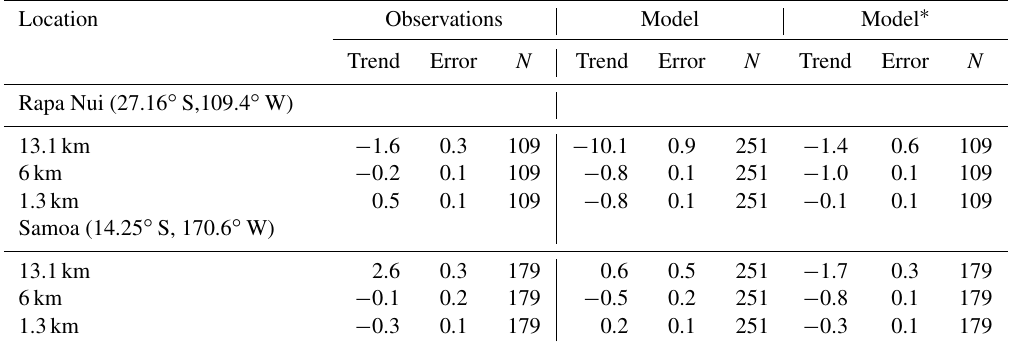
Table 3. Estimated decadal ozone trends (ppbv per decade) at different altitudes over Rapa Nui and Samoa in the Pacific Ocean according to observations and simulations for the period 1994–2014. Trends based on model values are calculated using all data points (“Model”) and only those for which there are concurrent observations (“Model ∗ ”). Trends are calculated following Lamsal et al. (2015) and errors as in Tiao (1990). The number of data points ( N ) considered is also indicated. Trends and errors are in ppbv per